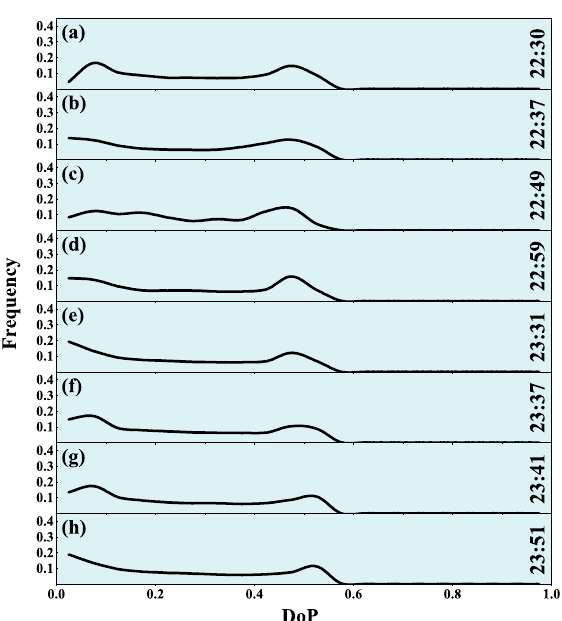
Figure 4. Celestial polarization patterns on 1 February 2018 at the same location and facility as on 31 January 2018. The Degree of Polarization (DoP; Table S3) and Angle of Polarization (AoP; Table S4) of the measurement are shown in the first, second, fourth, and fifth columns. The characteristics of the DoP along the lunar-anti-lunar meridian are shown in the third and sixth columns in which the dots and solid lines represent the values of DoP and their fitted curve, respectively. ( a – h ) Polarization patterns in normal sky corresponding to the recording time on 1 February in Table 2.